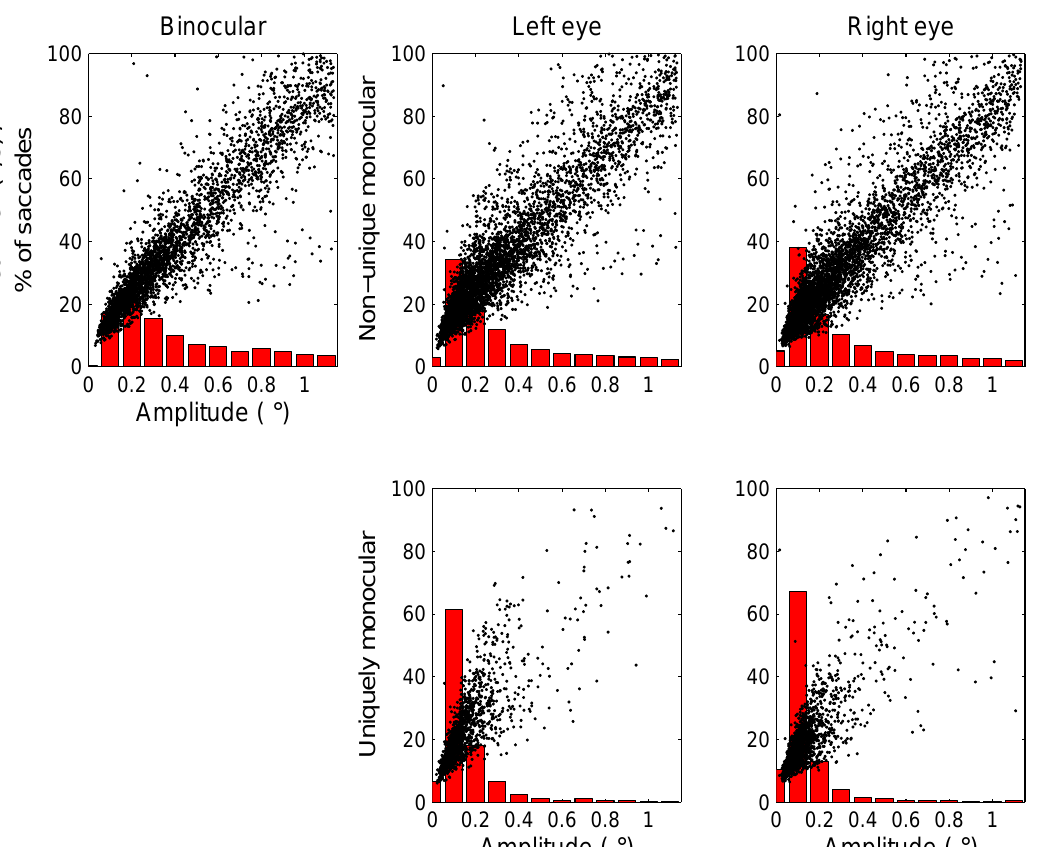
Figure 9 . Scatterplots (black dots) plotting saccade amplitude (horizontal axis) against peak velocity (vertical axis) for the different types of saccades (binocular, non-unique monocular and uniquely monocular microsaccades, either in the left or right eye). Red bars in the background show histograms of saccade